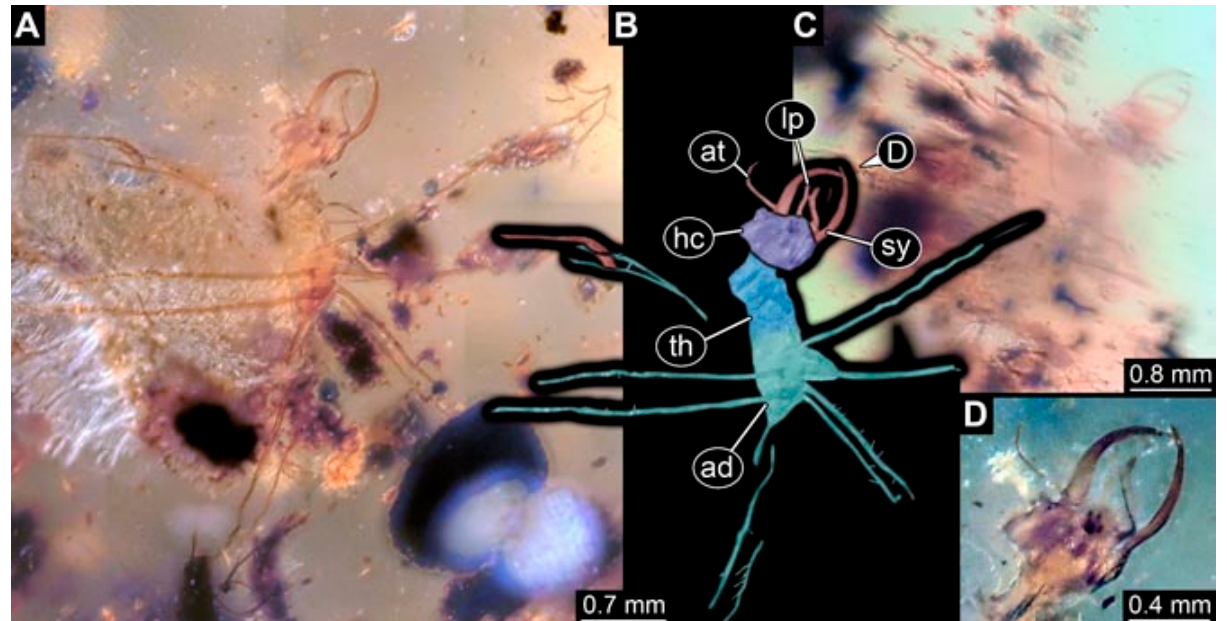
Figure 24. Specimen 4845 (PED 0541); Myanmar amber. ( A ) Ventral view. ( B ) Ventral view, colour- marked. ( C ) Dorsal view. ( D ) Close-up of head capsule in ventral view. Abbreviations: ad = abdomen; at = antenna; hc = head capsule; lp = labial palp; sy = stylet; th =